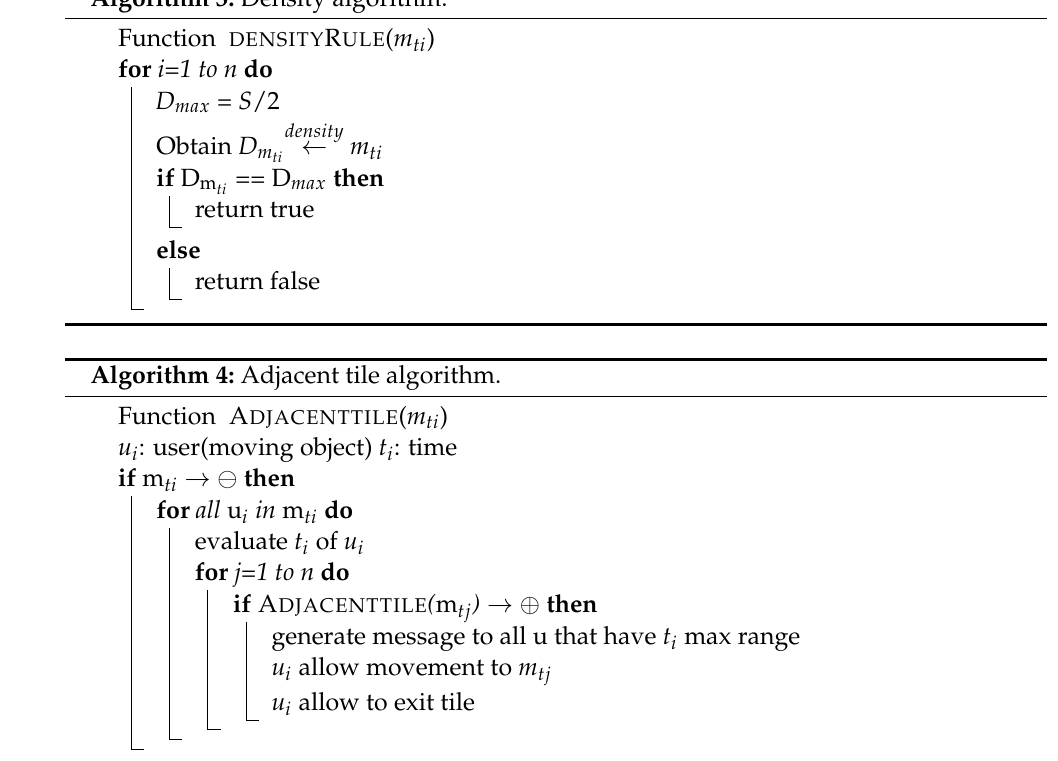
Algorithm 3: Density algorithm.